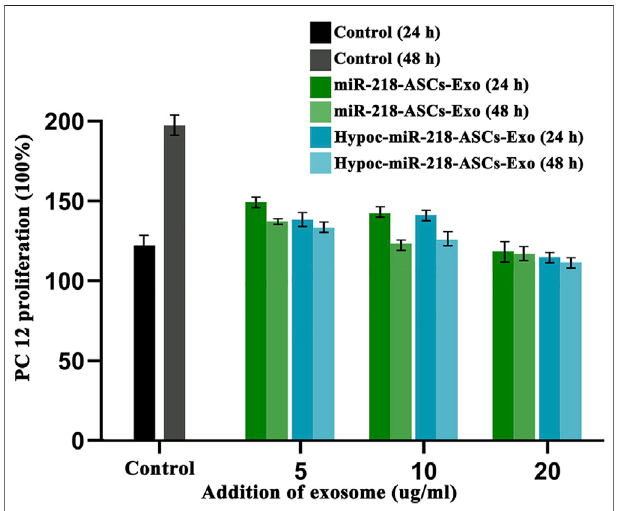
FIGURE 10 | Expression levels of miR-218 targeted genes ( Robo 1 , Robo 2 , Sfrp 2 , and Dkk 2 ) were examined by qRT-PCR in untreated PC12 cells (Control group), PC12 cells of transfected miR-218 plasmid, and two exosomes